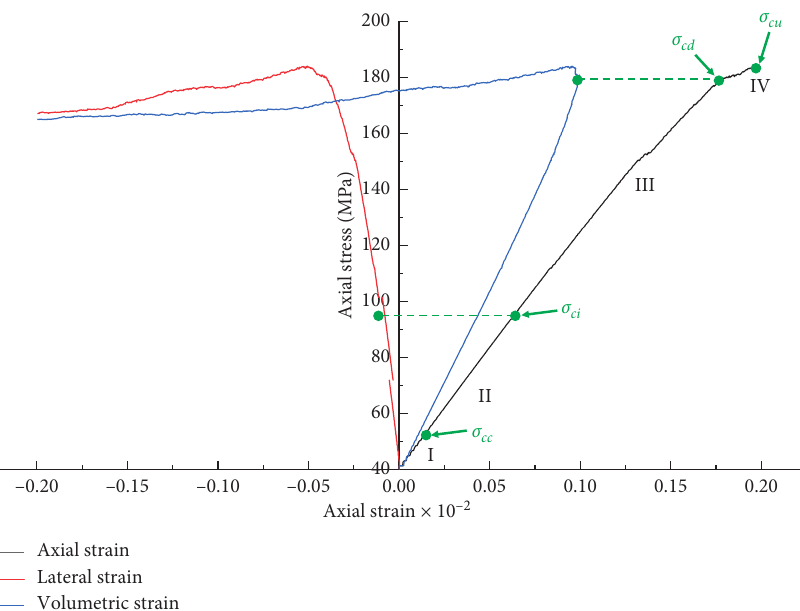
Figure 6: Three kinds of stress-strain relationships of marble under confining pressure of 40MPa.